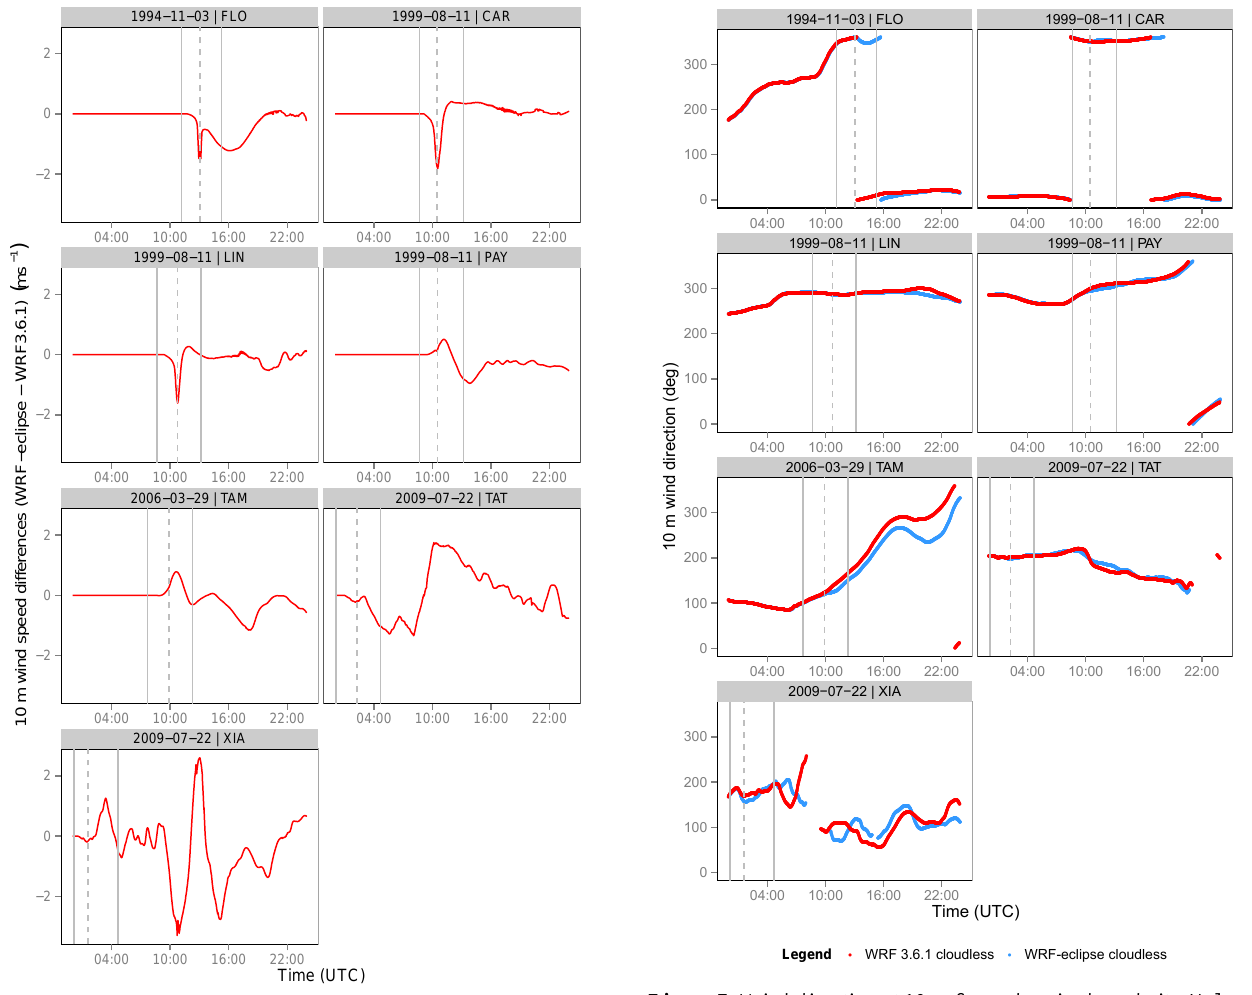
Figure 6. Wind speed differences at 10m for each episode and site. The first and second vertical gray solid lines indicate the time of FCTD and LCTD, respectively. The dashed vertical gray line shows the time of maximum obscuration. All results are expressed with 1min time resolution.